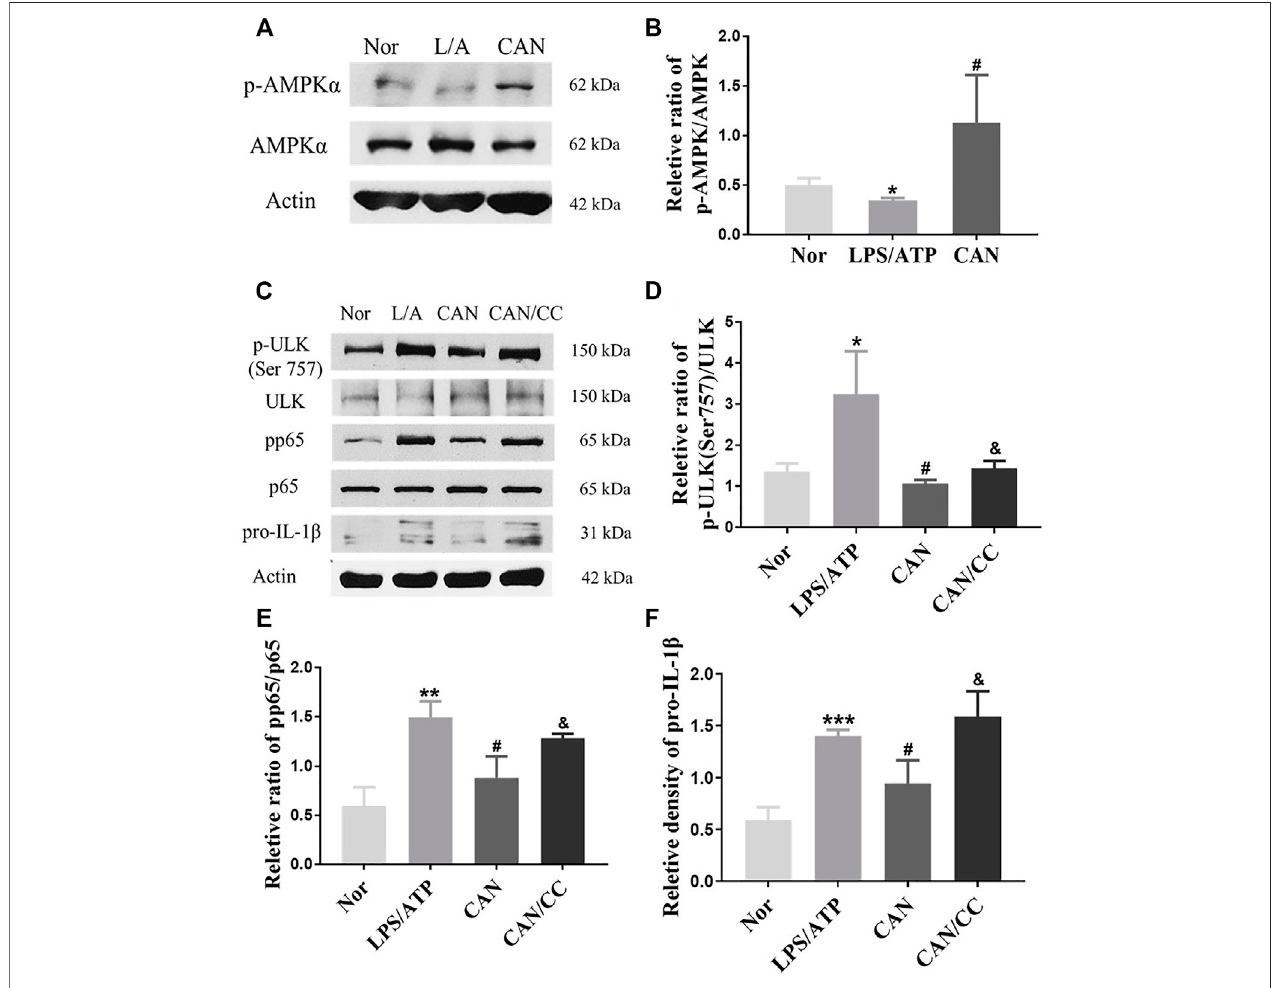
FIGURE 5 | Canagli fl ozin inhibits phosphorylation of p65 and ULK1 (Ser 757) by activating AMPK. (A,B) CAN upregulated phosphorylation of AMPK. (C – F) J774A.1cellswerepretreatedwithCompoundC(5 μ M)for1h,thenstimulatedwithLPS(500 ng/ml)inthepresenceorabsenceofCAN(10 μ M)for6 h,afterthat5 mM ATP was added. Whole cell lysiswas collected, phosphorylation ofp65, ULK1 (Ser 757) and protein level of pro-IL-1 β were assayed using western blotting. Nor, normal control group; LPS/ATP (L/A), untreated LPS/ATP control group; CAN, CAN-treated LPS/ATP group; CAN/CC, Compound C-treated CAN group. Data were expressed as mean ±SD ( n =3). Differences with aprobability value of < 0.05 wereconsidered signi fi cant(* p < 0.05, ** p < 0.01, *** p < 0.001 vs. Nor; # p < 0.05 vs. LPS/ ATP; & p < 0.05 vs. CAN).